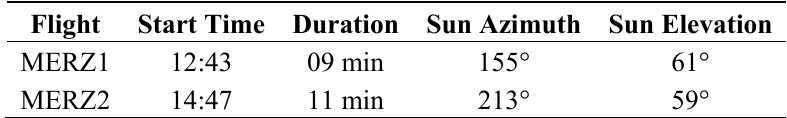
Figure 2. Wheat ( Triticum aestivum ) at the study site Merzenhausen, Germany, at the time of the multiangular flights, 18 June 2013. Ears were fully developed but still green. Table 1. Local time and duration with the corresponding sun angle parameters for the two hyperspectral flights performed over wheat field in Merzenhausen, Germany. Flight Start Time Duration Sun Azimuth Sun